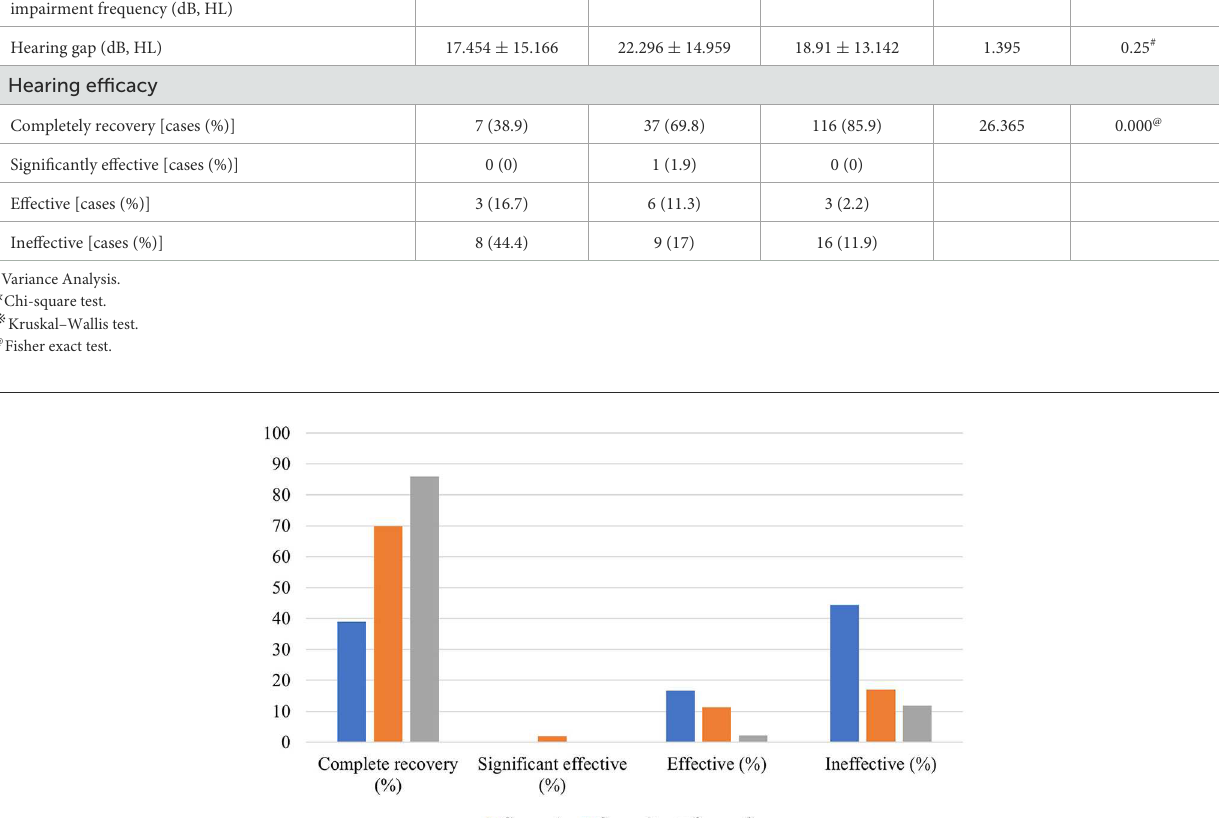
> 0.05). Moreover, there was no significant difference in the proportion of patients with different hearing efficacy grading among patients in the three groups ( P > 0.05) (Table 7, Figure